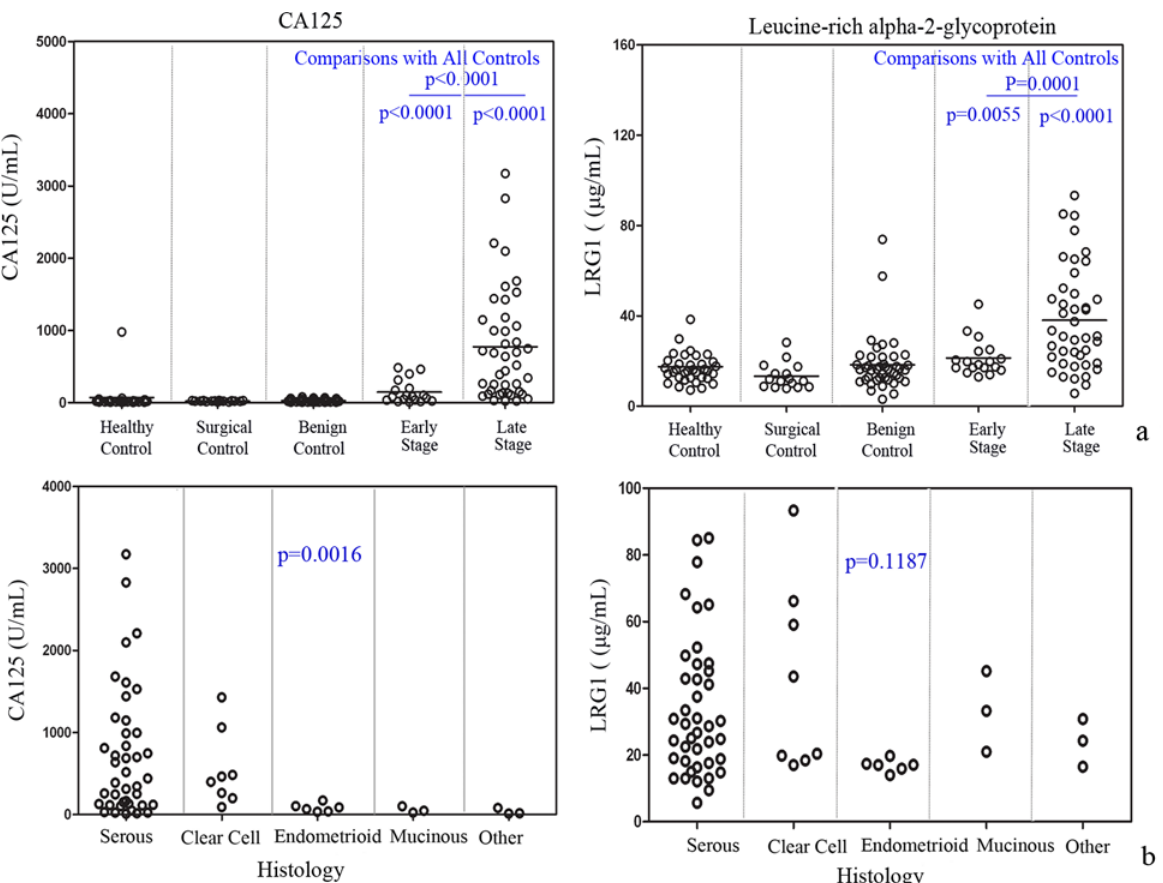
Fig 1. Serum marker levels for sample set 1. (a) The levels of CA125, and LRG1 were examined in the serum from healthy controls, surgical controls, benign diseases, stage I/II EOC, and stage III /IV EOC. * p < 0.05 indicates a significant difference between pairwise comparisons (all cases vs. all controls; early stage cases vs. all controls; late stage cases vs. all controls). (b) Marker distributions for the EOC patients from sample set 1 with different histological subtypes.